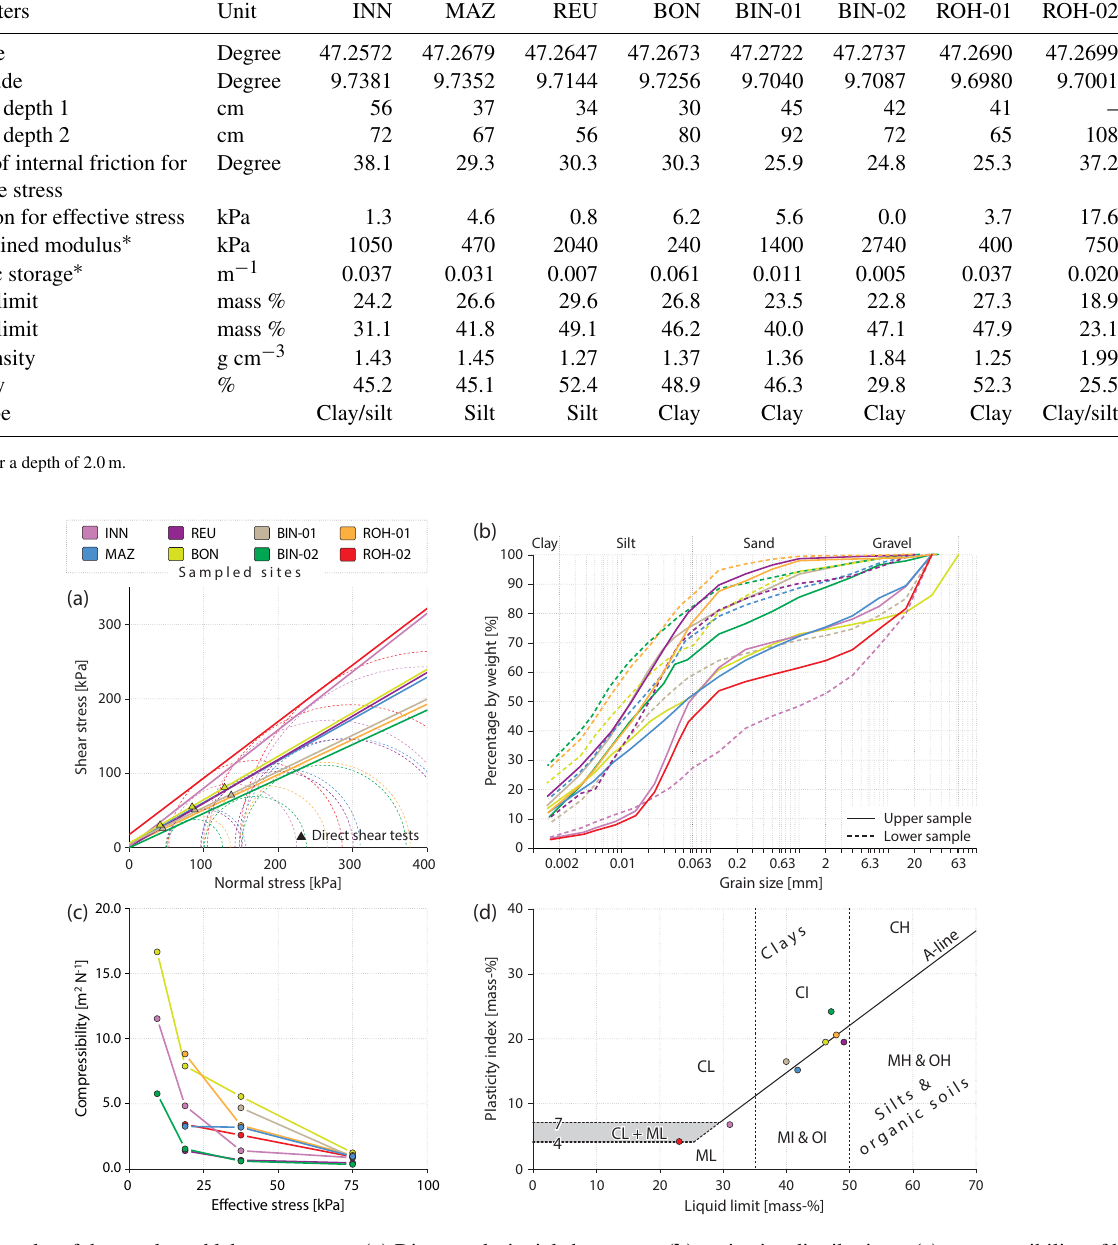
Figure 6. Results of the conducted laboratory tests. (a) Direct and triaxial shear tests, (b) grain size distributions, (c) compressibility of bulk soil and (d) Atterberg